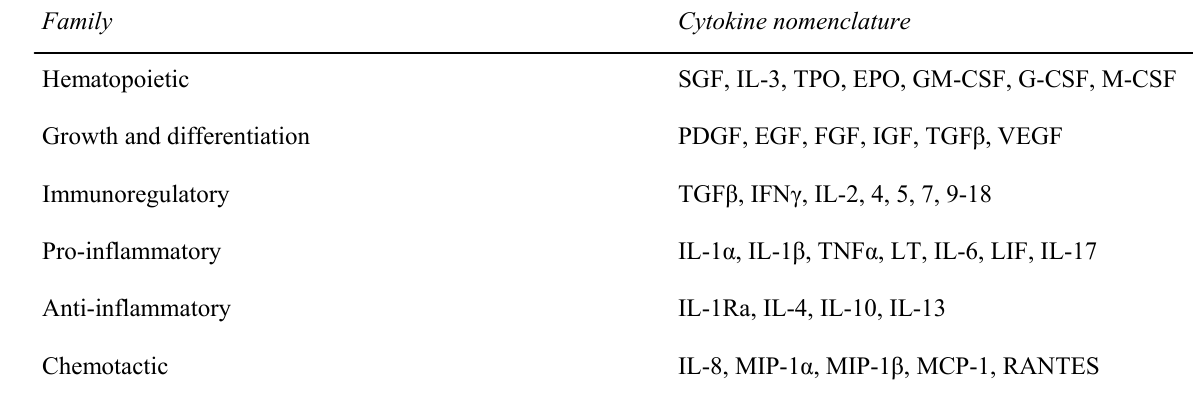
Table 3 . Classification of cytokines